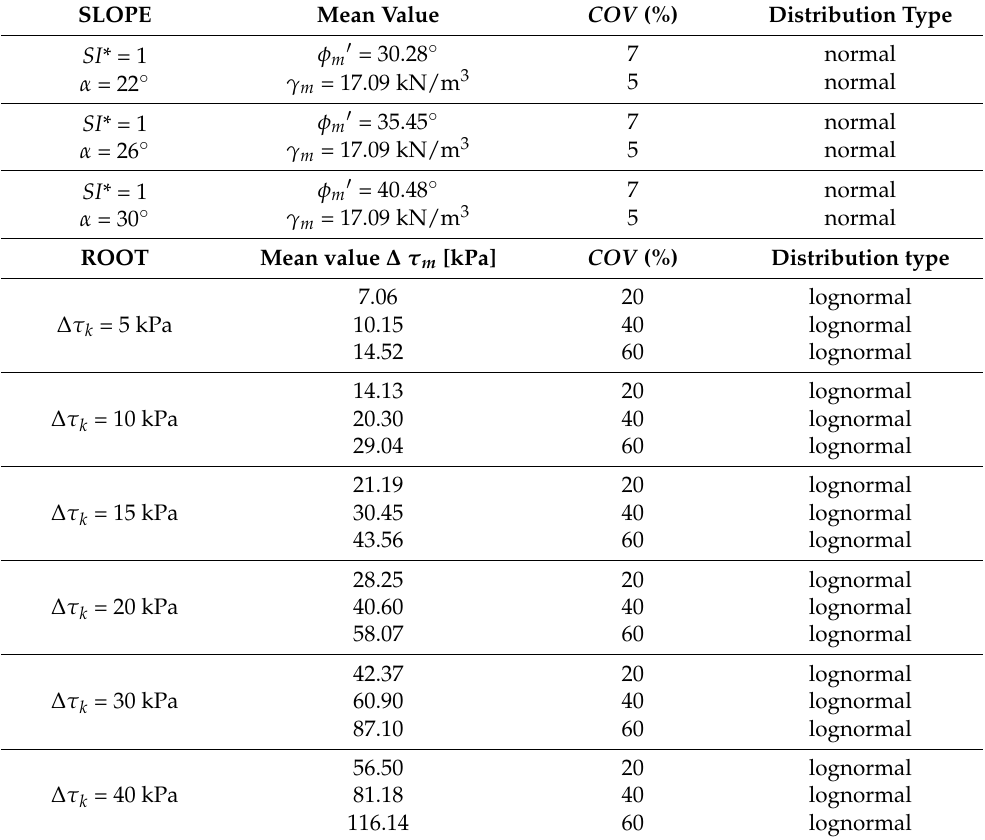
Table 4. Statistics used in this